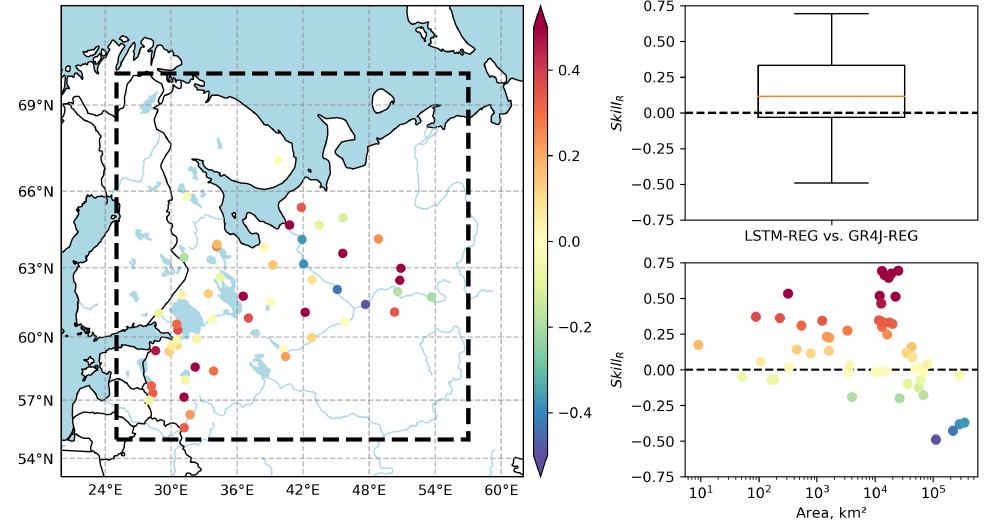
Figure 12. The correlation-based skill of LSTM-REG against GR4J-REG for the evaluation set of basins: map ( left plot ) represents the spatial distribution of skill, box plot ( top right plot ) represents the distribution properties of skill, scatter plot ( bottom right plot ) demonstrates the interconnection between skill and basin area. The skill is computed according to Equation (4) based on daily